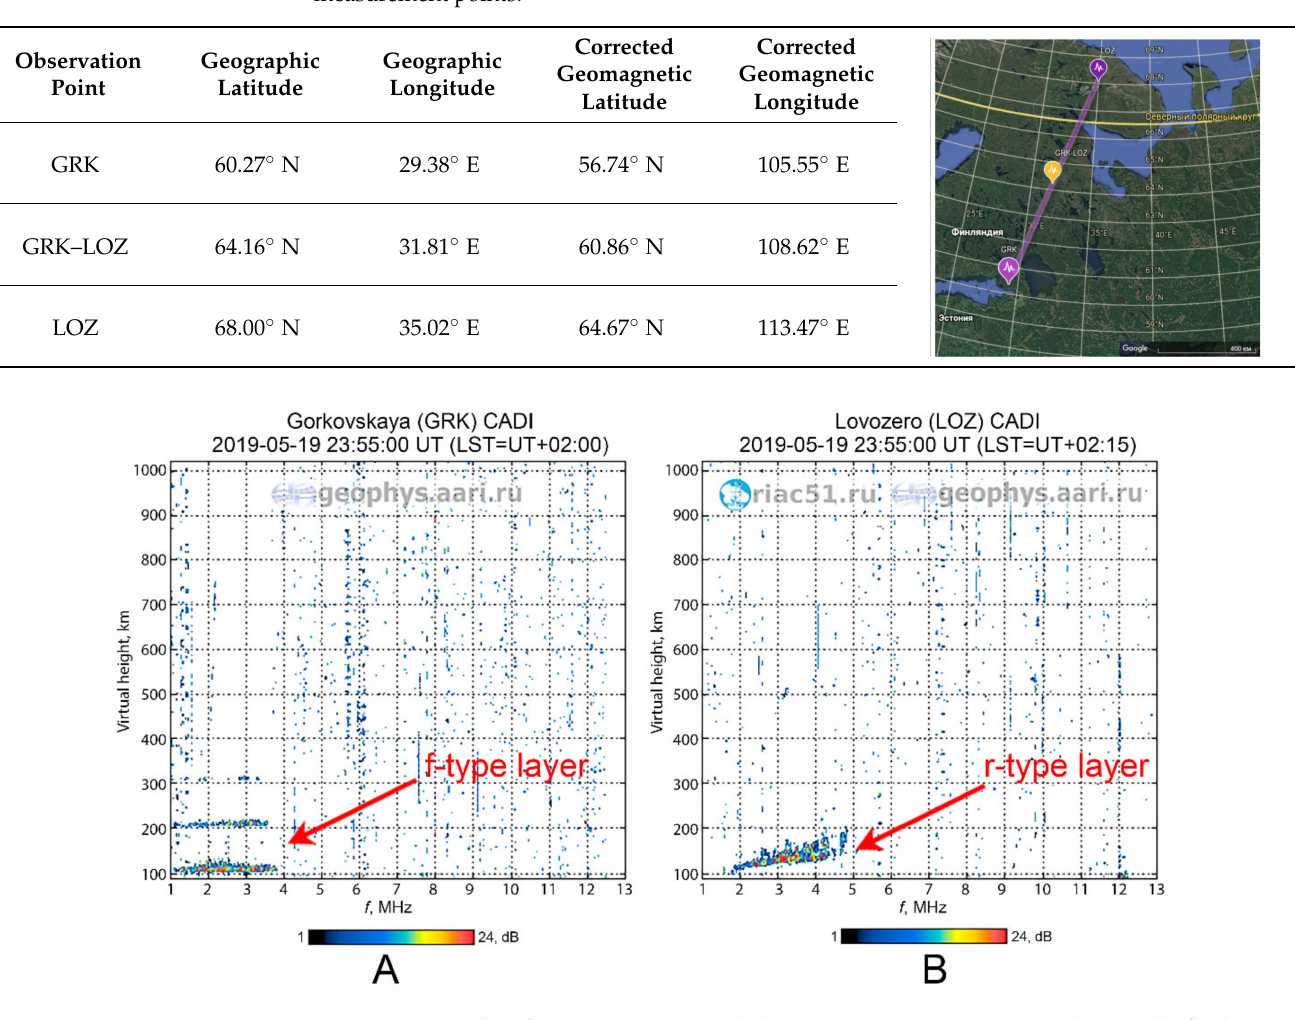
Figure 4. Examples of VS ionograms recorded on 19 May 2019 at 23:55 UT: ( A ) Sporadic flat layer at Gorkovskaya station; ( B ) Thick sporadic layer at Lovozero